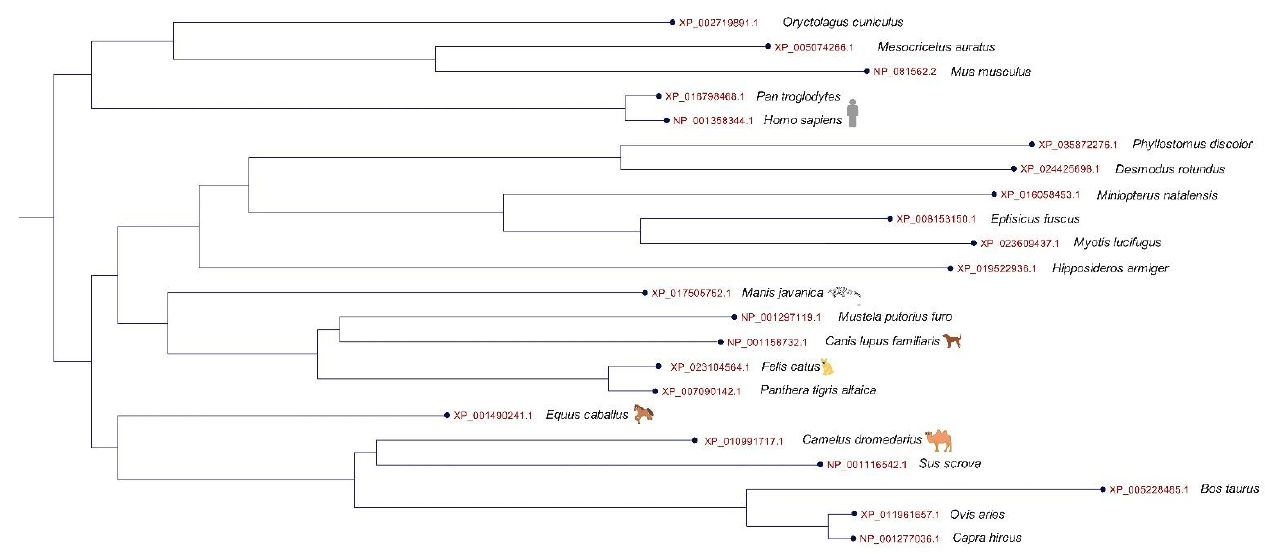
Figure 1. Phylogram of the angiotensin-converting enzyme 2 (ACE2) receptor amino acid sequences in humans and different animals including dogs, cats, pangolin. The ACE2 amino acid sequences were downloaded from NCBI, and the tree was generated using a maximum likelihood estimate under a JTT model and with a bootstrap 1.000. The phylogenetic tree was constructed using MEGA X software.